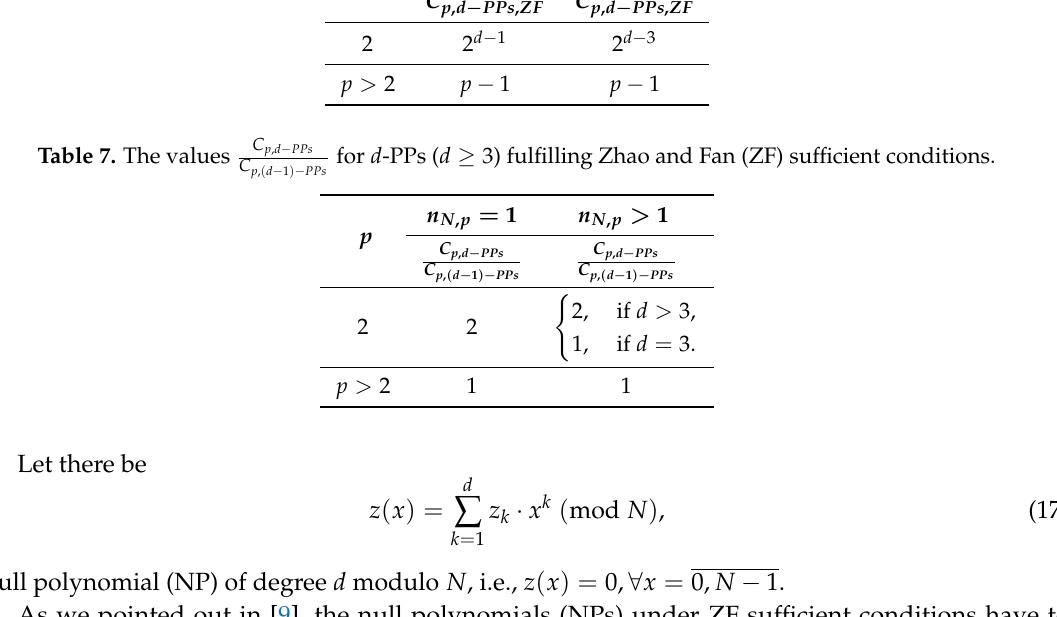
Table 6. The number of d -permutation polynomials (PPs) ( d ≥ 3) fulfilling ZF sufficient conditions over Z p permuting Z , with n N , p ≥ 1. p nN , p n N , p = 1 p